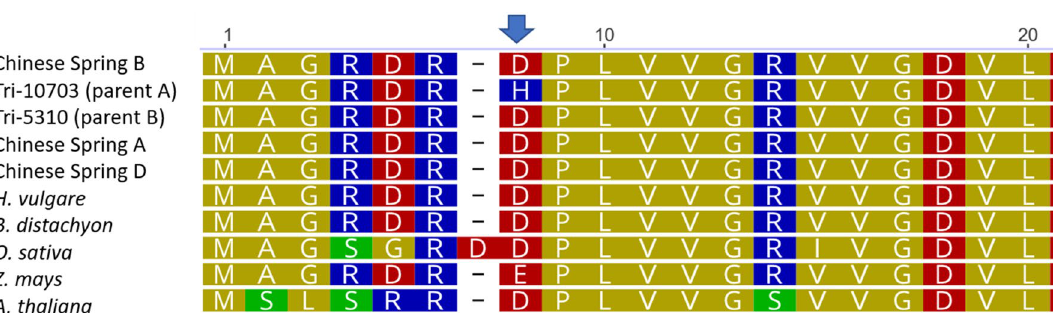
Figure 6. Sequence alignment of the 20 first amino acids of a subset of FT-B1 homologs including the homoeologues on chromosome 7A and 7D. The wheat reference sequence (Chinese Spring), the sequences of the two parental lines, and FT-B1 homologs in diverse species viz. Hordeum vulgare , Brachypodium distachyon , Oryza sativa , Zea mays , and Arabidopsis thaliana . The blue arrow indicates the position of the aspartic acid (D) to histidine (H) mutation present in the parent A and associated with elevated total spikelet number. The amino acids are color coded according to their side chain polarity with nonpolar (gold), polar (green), basic polar (blue), and acidic polar